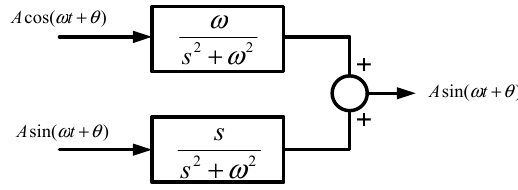
Figure 4. Positive sequence integral equation.